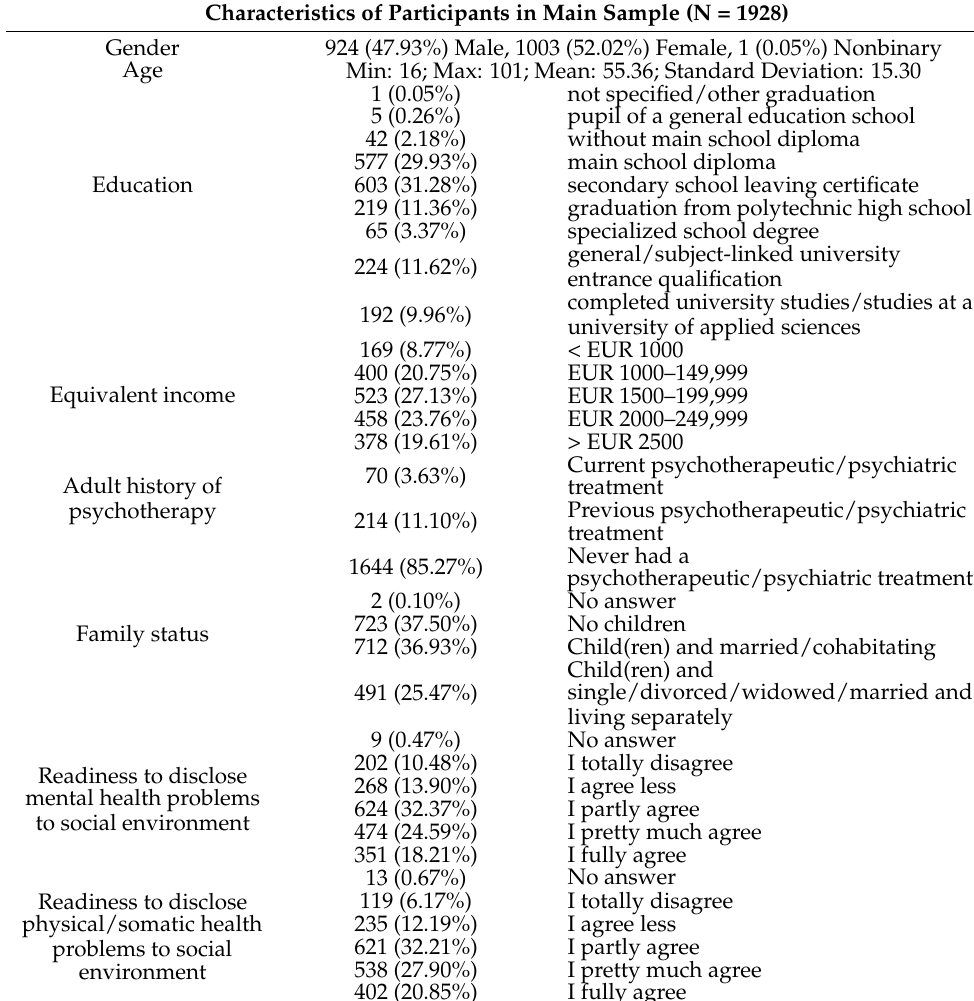
Table 1. Sociodemographic description of the main sample (all